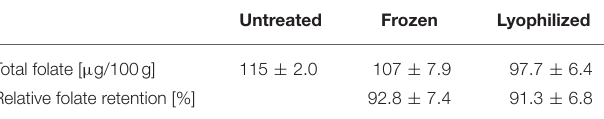
TABLE 3 | Total folate content calculated as PteGlu in [ µ g/100g] of fresh strawberries compared to frozen and lyophilized strawberries and the relative folate